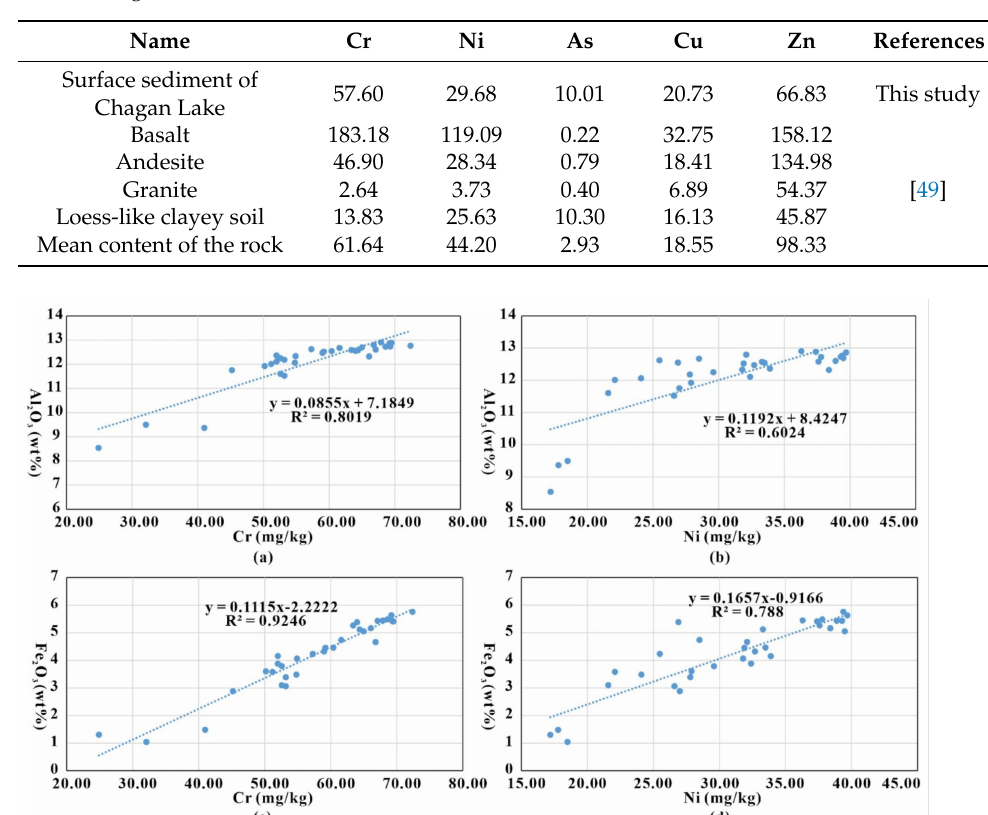
Table 4. Comparison table of element contents in sediments and rocks from Chagan Lake and its surrounding areas.